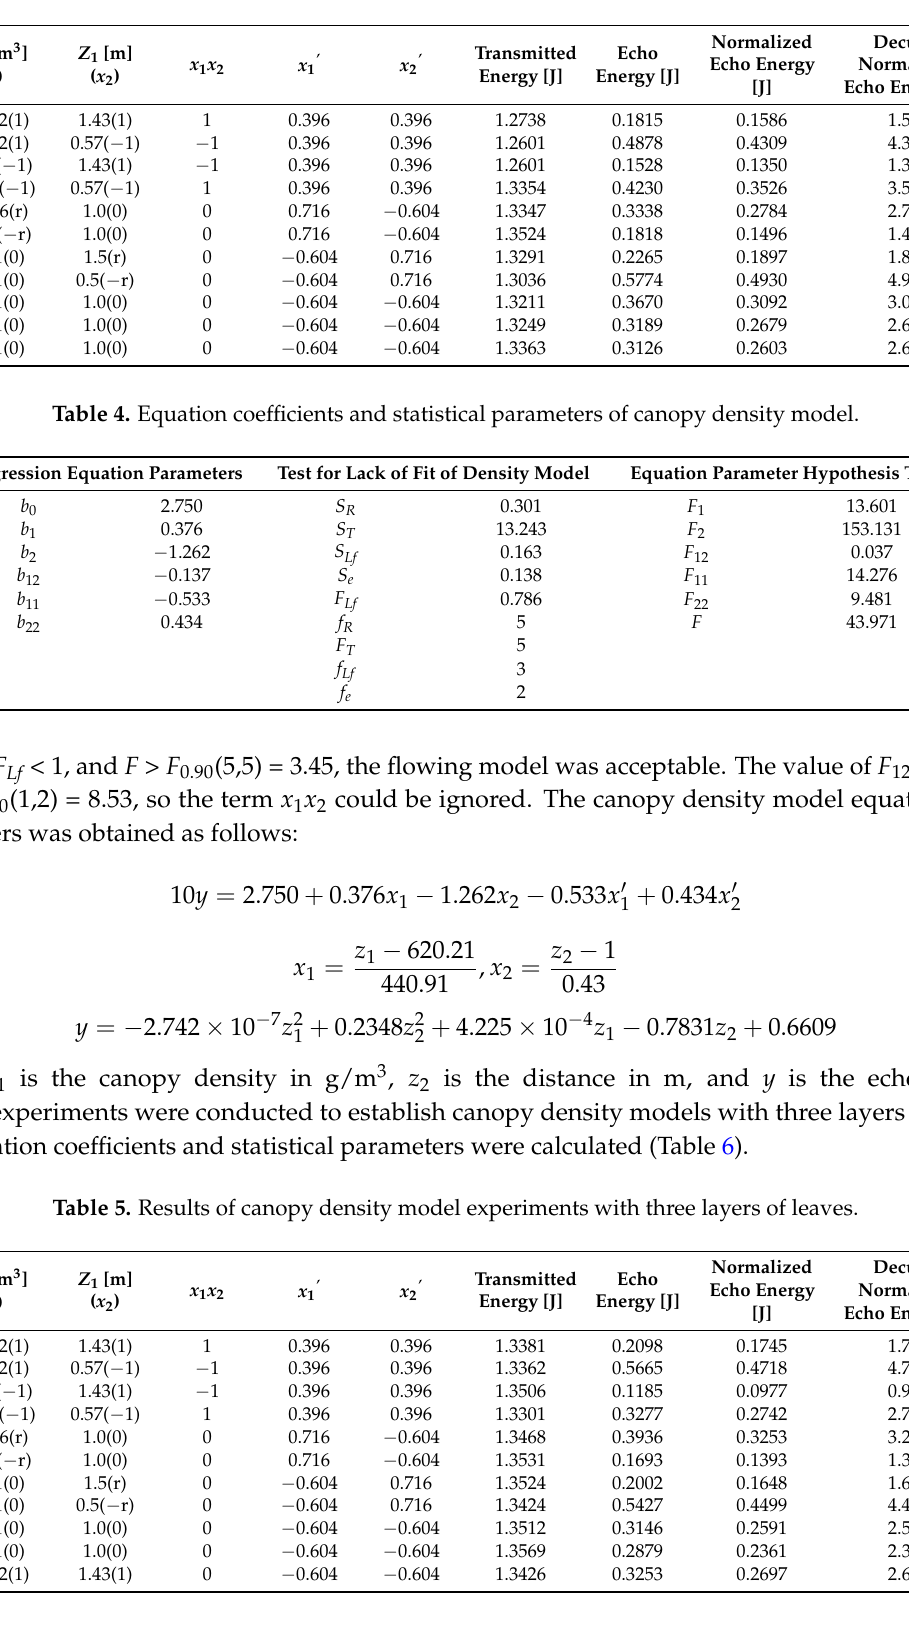
Table 3. Results of canopy density model experiments with 4 layers of leaves.